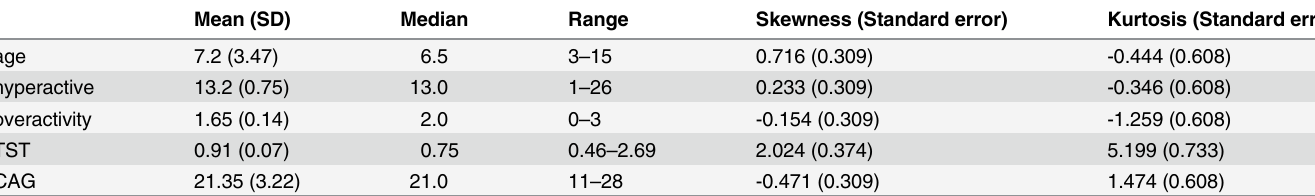
Plasmatic levels of testosterone were measured in 40 boys (n = 40) with